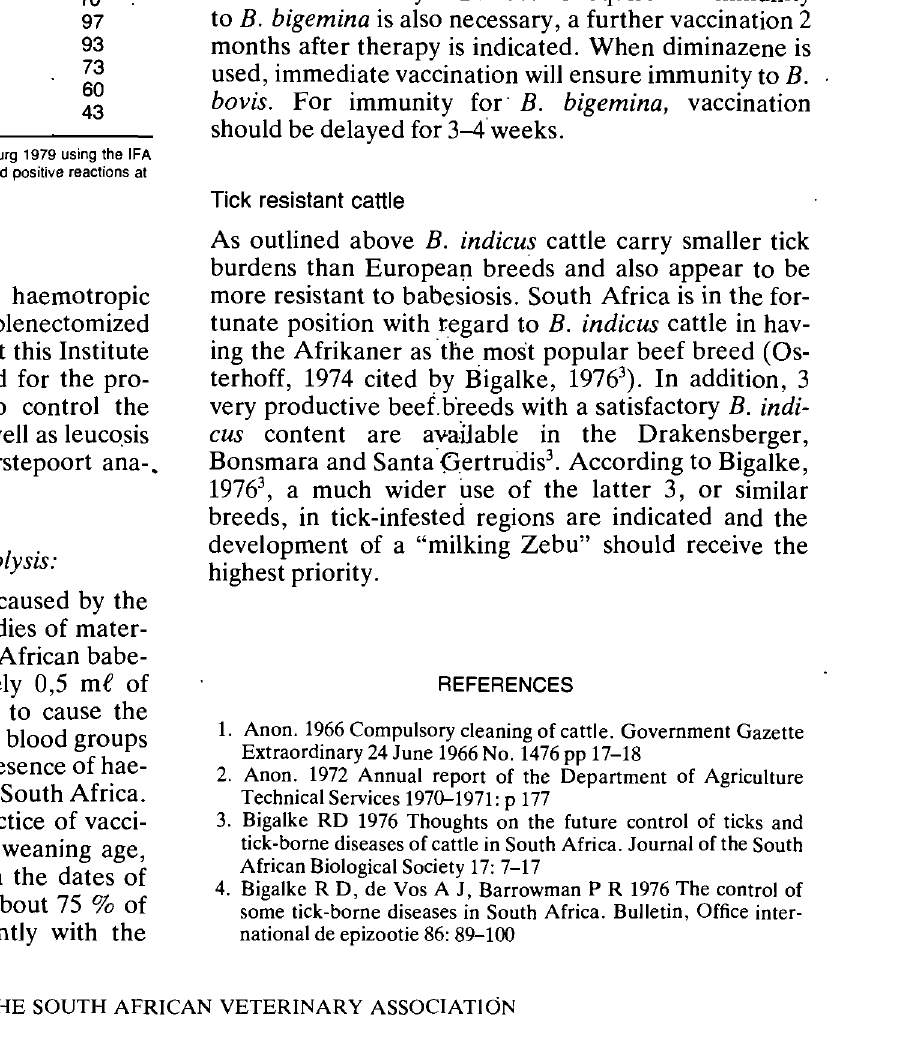
Table 6: PERCENTAGE OF ANIMALS SEROLOGICALLY POSITIVE AT VARIOUS INTERVALS AFTER VACCINATION